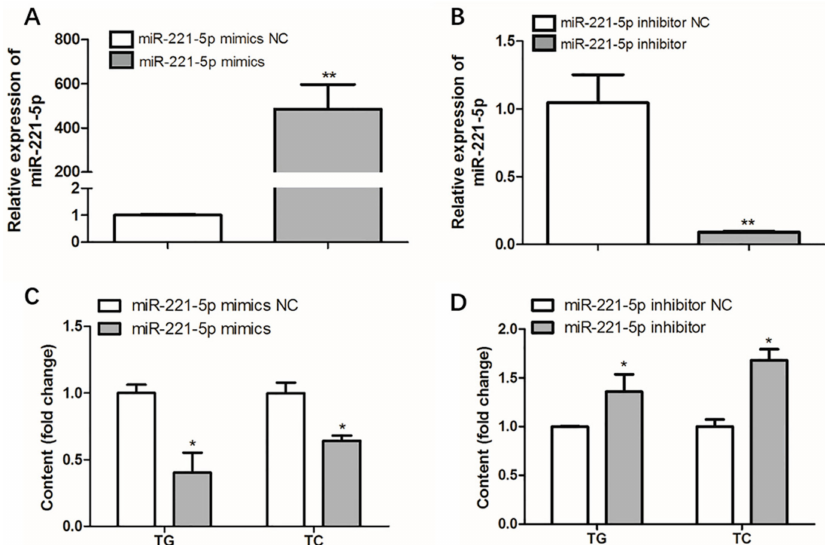
Figure 7. E ff ect of gga-miR-221-5p overexpression and inhibition on intracellular triglycerides (TG) and cholesterol (TC). ( A , B ) The expression of gga-miR-221-5p under the gga-miR-221-5p overexpression and inhibition in LMH chicken hepatoma cells, respectively. ( C , D ) Changes of TG and TC contents under gga-miR-221-5p overexpression and inhibition in LMH chicken hepatoma cells, respectively. Data are represented as mean ± SD ( n = 6). * means 0.01 < p < 0.05, ** means 0.001 < p <